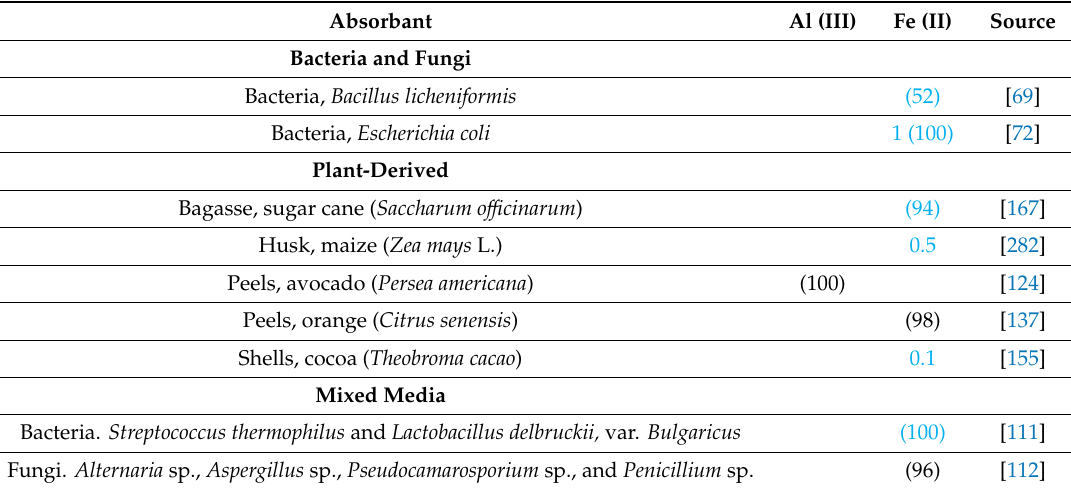
Table A1. Removal of ubiquitous metals with limited toxicity in the developing world, in mg / g or (% removal) (Peruvian studies in black